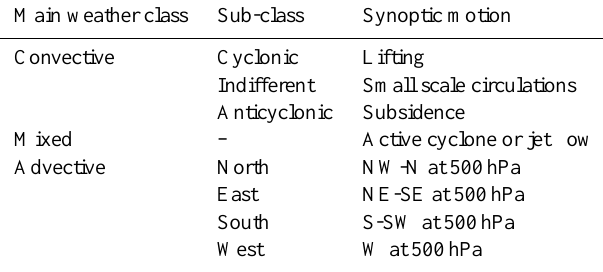
Table 1. Weather classes according to the Alpine Weather Statistics (AWS): three main classes are defined and thereof eight sub-classes. Sub-classes are characterized by the synoptic scale motion